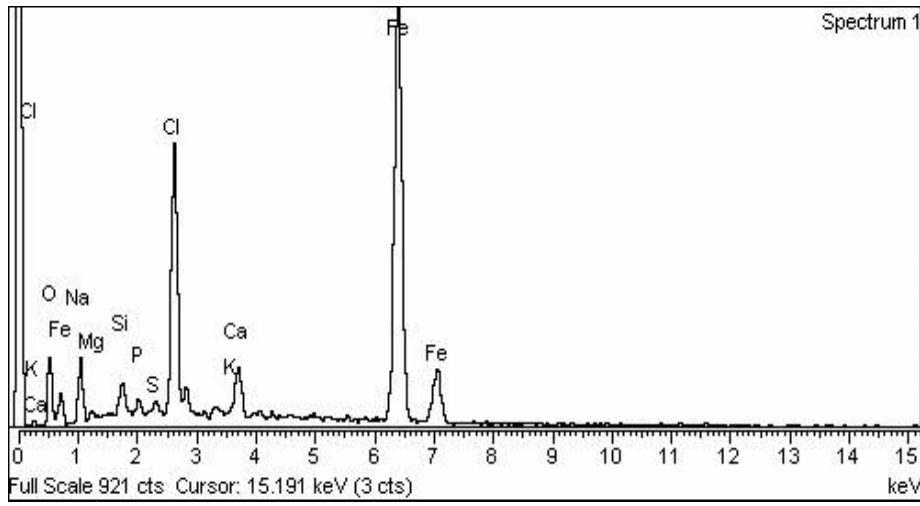
Figure 6. Energy-dispersive X-ray spectroscopy (EDX)EDX spectra showing the elemental composition of IONPs.